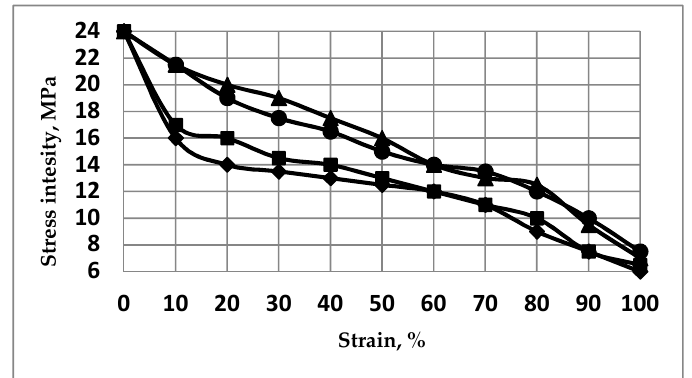
Figure 11. Strain level (%) versus the strained relative volume of the sample (%) versus the ECAP passes: diamonds ( ♦ ): 1st pass, triangles ( ▲ ): 2nd pass at φ = 90°, being the optimal combination, mode B C . Black squares ( ■ ): 2nd pass at φ = 180°, mode A, black circles ( ● ): 3rd pass at φ = 90° relative to the 2nd pass at φ = 90°, mode B C .